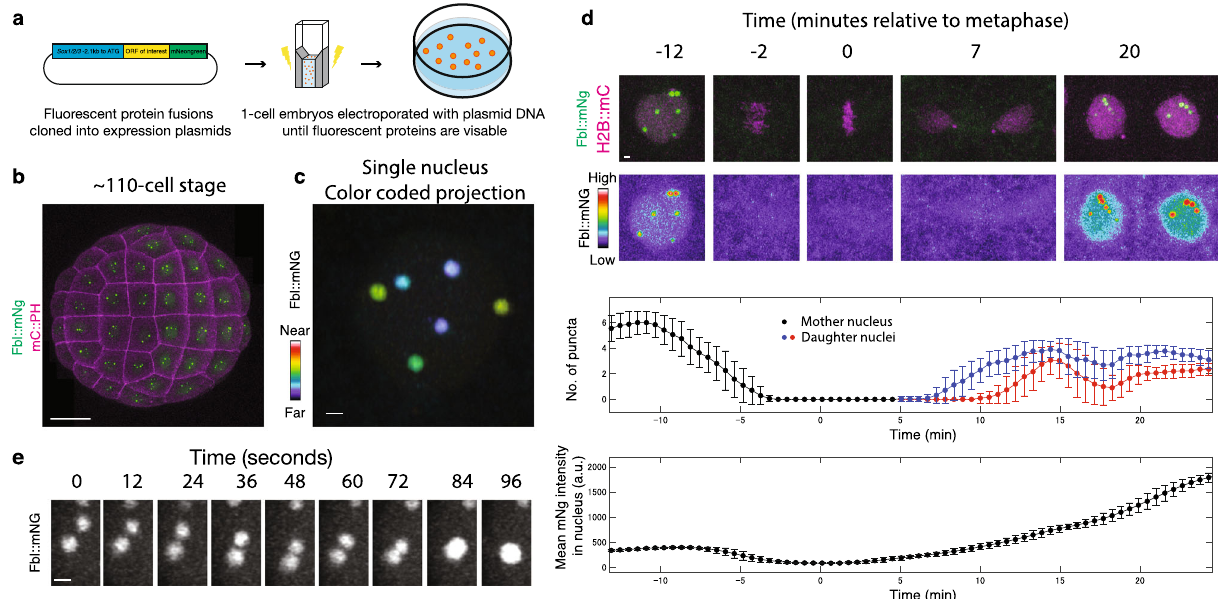
Fig. 1 The nucleoli of Ciona embryos show liquid properties. a Schematic of the electroporation procedure used to transfect Ciona embryos with plasmid DNA. b Confocal maximum intensity projection of a whole Ciona embryo expressing a Fbl::mNg transgene Scale bar = 20 μ m. c Color coded projections of a single nucleus expressing Fbl::mNg. Scale bar = 1 μ m. d Time-lapse maximum intensity projection confocal images of a single Ciona nucleus from the 7th to 8th mitosis. Fbl::mNg is shown in green and with the indicated look up table. H2B::mCh is shown in magenta. Graphs depict properties of green fl uorescence within the red fl uorescence region. Scale bar = 1 μ m. Each central data point is the average over 30 frames (see methods). Error bars show the standard deviation. Scale bar = 1 μ m. e Time-lapse maximum intensity projection confocal images of the fusion of 2 nucleoli. Scale bar = 0.5 μ m. All images are representative of >3 biological replicates. Source data are provided as a Source Data fi